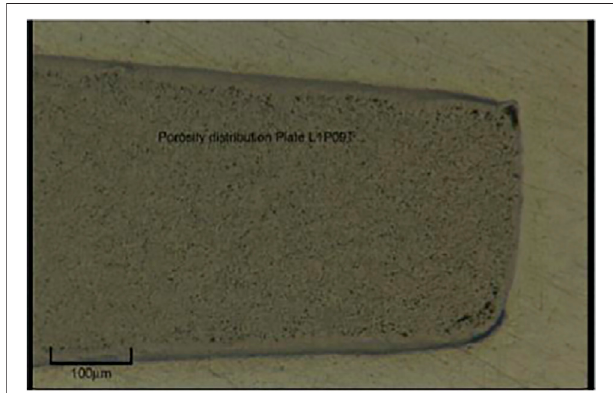
FIGURE 1 | Post irradiation section of a UMo fuel meat (Rice, 2010)